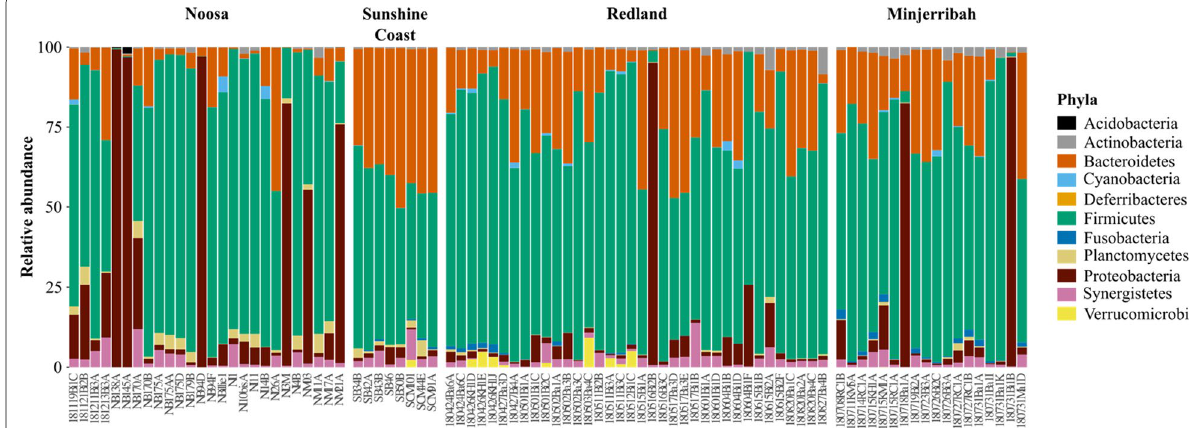
st ) calculations